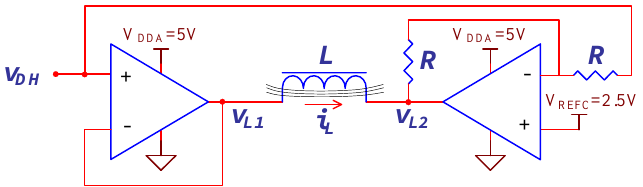
Figure 6. Magnetic drive circuit